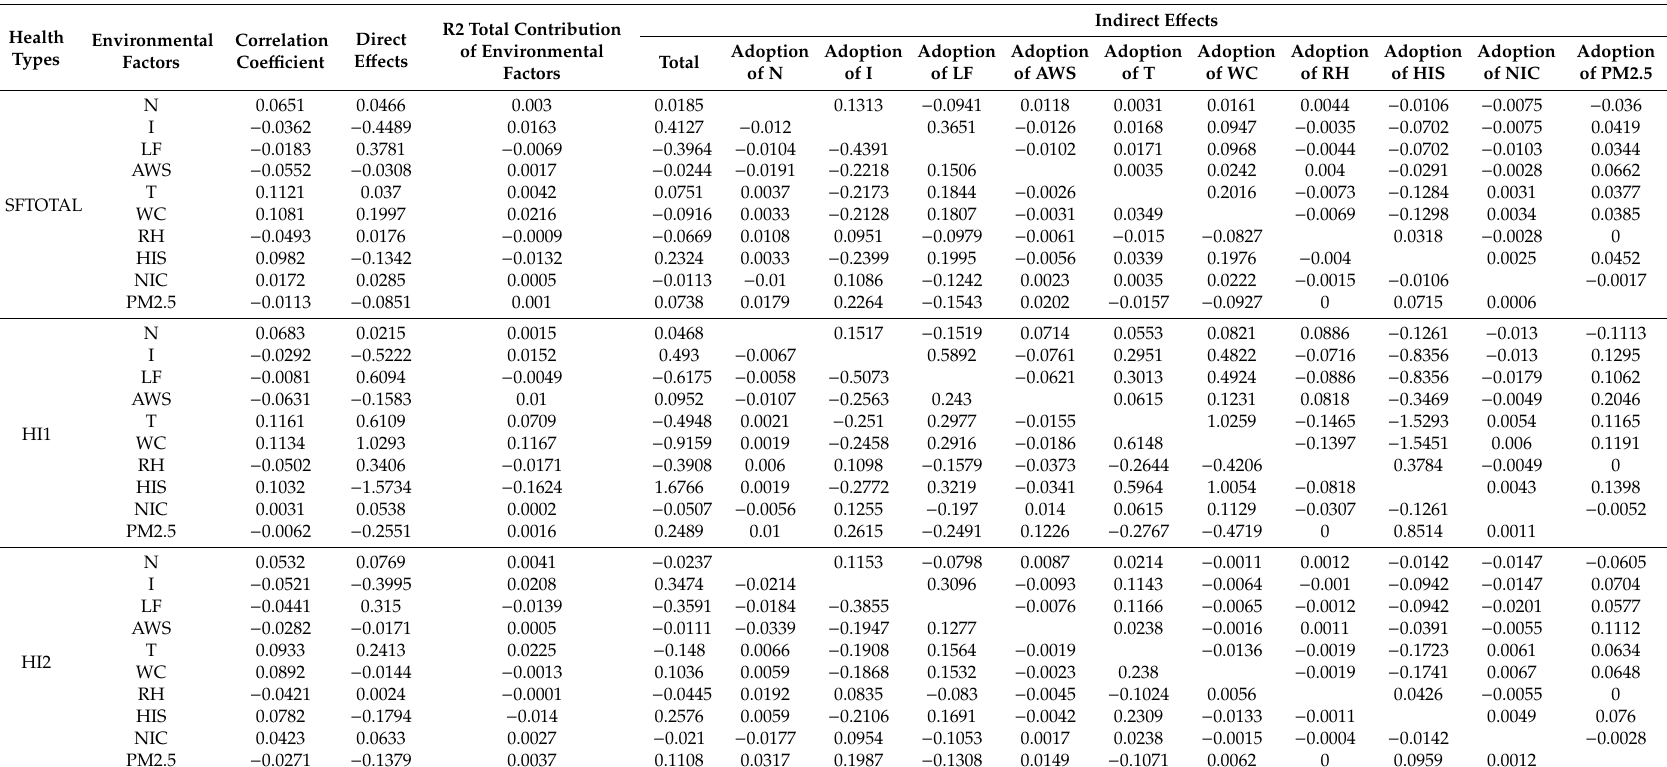
Table 8. Path analysis of health types by environmental